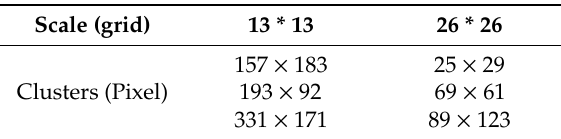
Table 2. Size of 6 clusters at each scale .